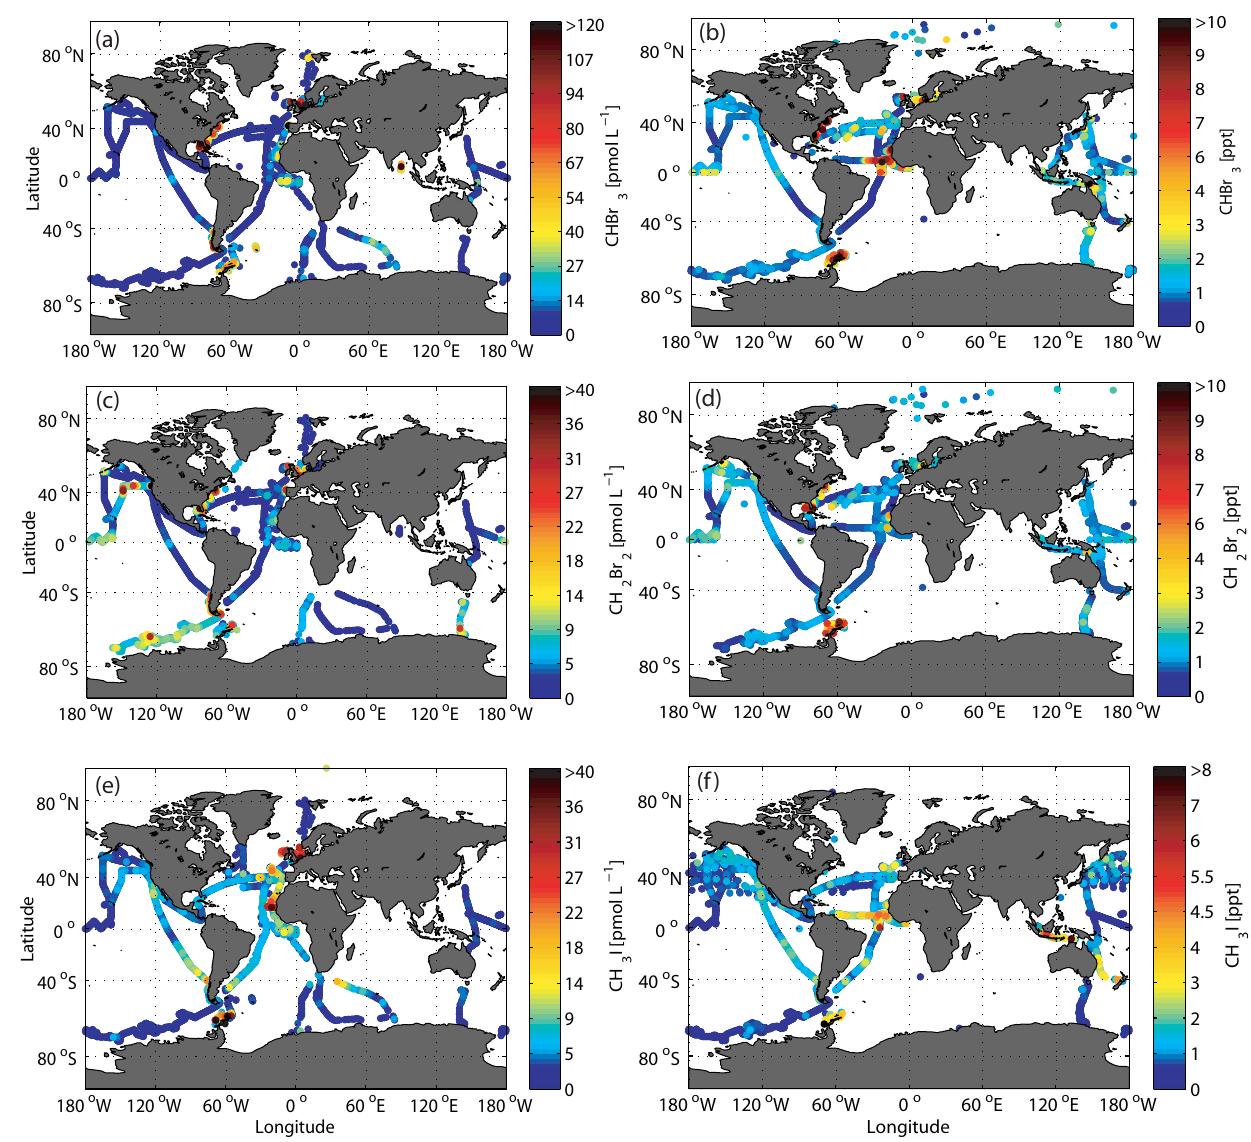
Fig. 1. Global coverage of available surface seawater measurements in pmolL − 1 and atmospheric measurements in ppt for bromoform (a, b) , dibromomethane (c, d) and methyl iodide (e, f) from the HalOcAt database project (data from 1989 to